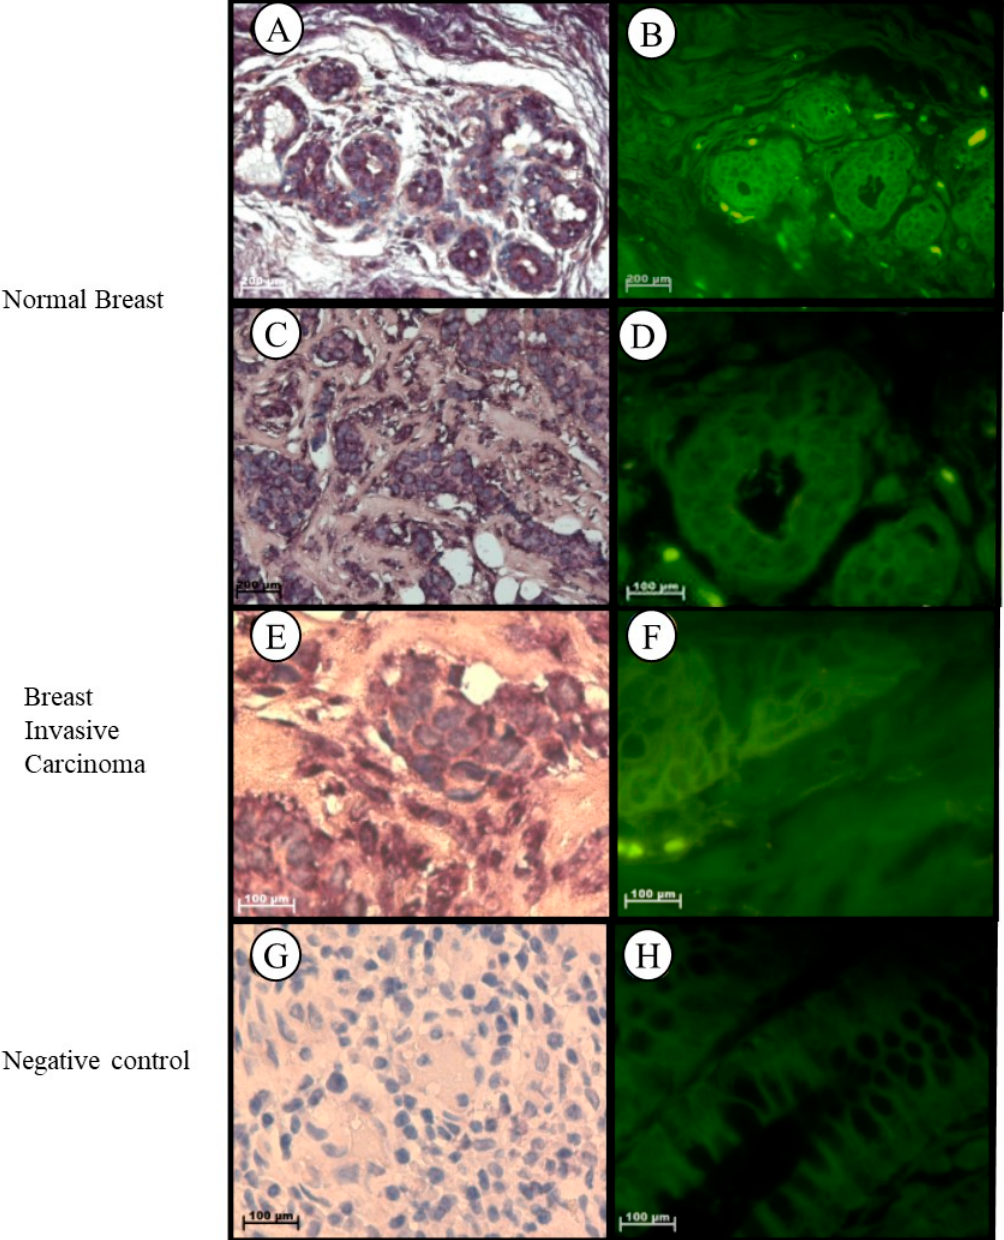
Figure 7. Subcellular Localization of Tspo mRNA in healthy and diseased Breast Tissue: Tspo mRNA is present in both healthy breast tissue ( A , B ) and Grade III invasive carcinoma (NST) ( C , D ). In normal breast tissue ( A – D ) Tspo is localized to the cytoplasm of the luminal layer of cuboidal epithelial cells and the outer layer of discontinuous epithelial cells of the terminal ducts (T) and alveoli (A), in cytoplasm of collagen fibres of the fibroconnective tissue, in nuclei and cytoplasm of lymphocytes and in the nuclei of endothelial cells of the vascular tissue located in the intralobular stroma. In Grade III invasive carcinoma (NST) ( E , F ) Tspo mRNA localizes to the cytoplasm of tumour cells arranged as nests and collagen fibres of the fibrotic stroma and in the nuclei and cytoplasm of lymphocytes located between the tumour and stroma, indicating the presence of a mononuclear infiltrate. ( G , H ) Negative control for the subcellular localization of Tspo mRNA. Sense probes were used to probe tissue preparations and this was analysed colorimetrically and fluorescently . Tissues are magnified at 1000×.